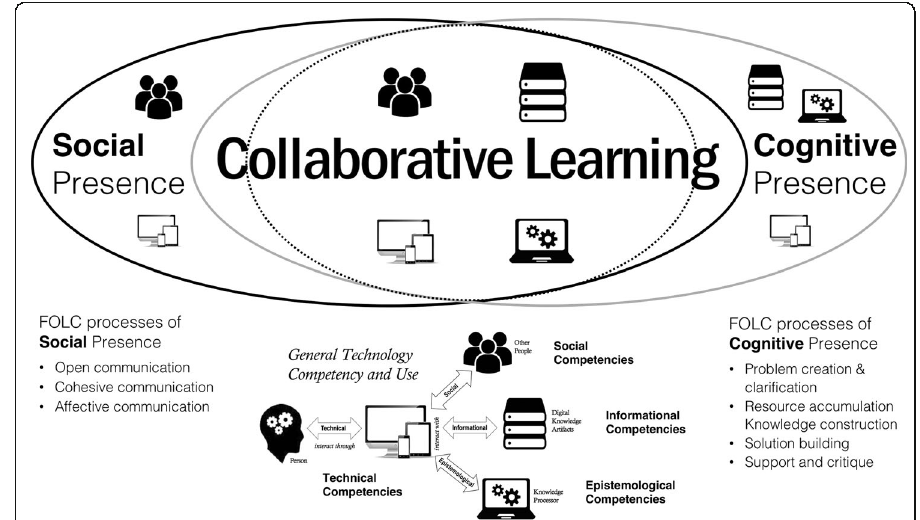
Fig. 2 Digital Competencies Supporting Processes of Fully Online Learning. The Fully Online Learning Community (FOLC) model associates key processes of collaborative learning (categorized by Social and Cognitive Presence) with digital competencies defined by the General Technology Competency and Use (GTCU) framework (Desjardins, 2005). GTCU competencies, organized into four orders of human-computer-human interaction, may be layered onto the FOLC model (as show above) to map the specific types of digital competencies required for suc- cessful collaborative learning in digitally rich